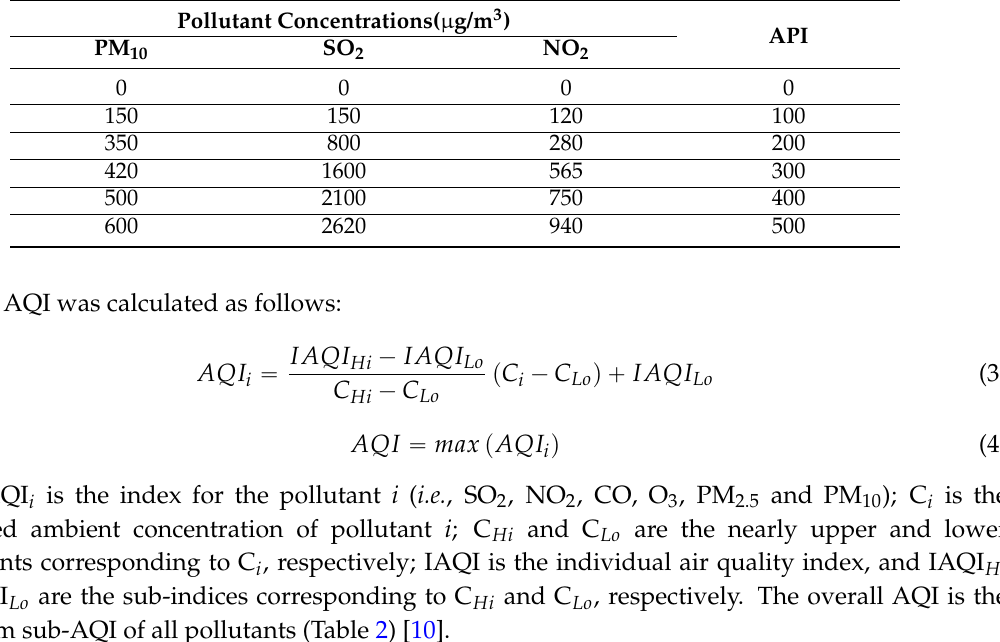
Table 1. The concentration breakpoints for each pollutant in the calculation of the Air Pollution Index (API).